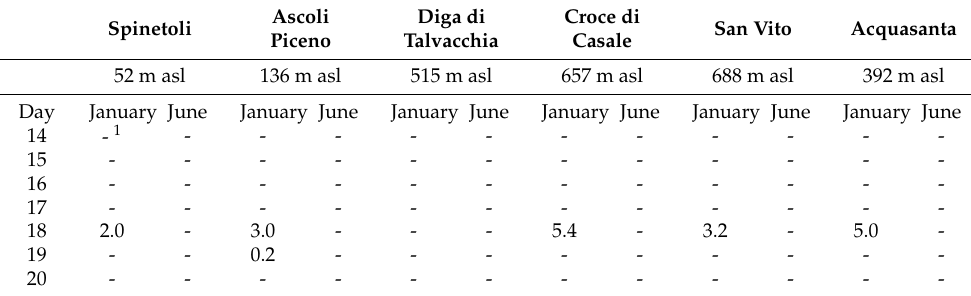
Table 1. Daily precipitation (mm) at some rain-gauge stations during the investigated